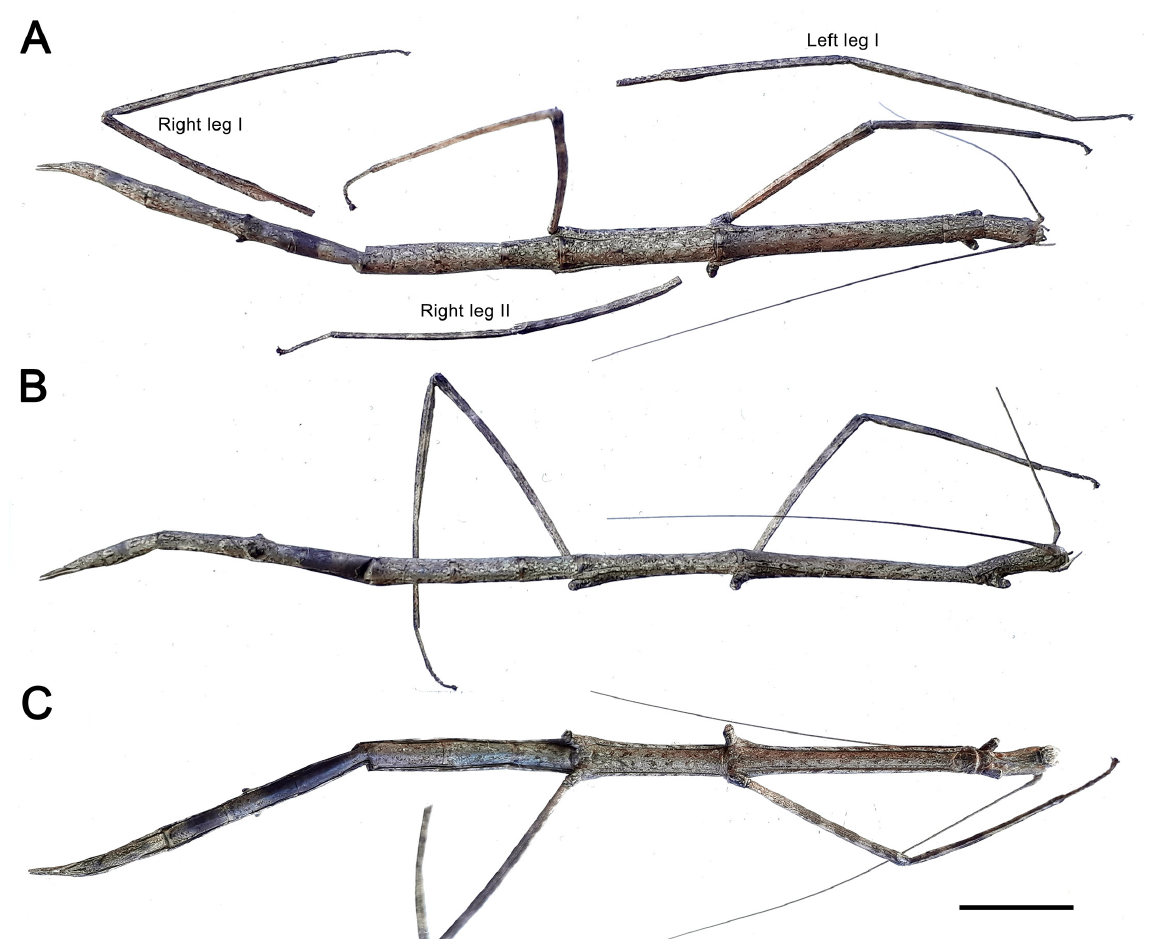
Fig. 47. Arumatia diamante Ghirotto gen. et sp. nov., holotype, ♀ (MZUSP V0650). A . Dorsal view. B . Lateral view. C . Ventral view. Scale bar: 10